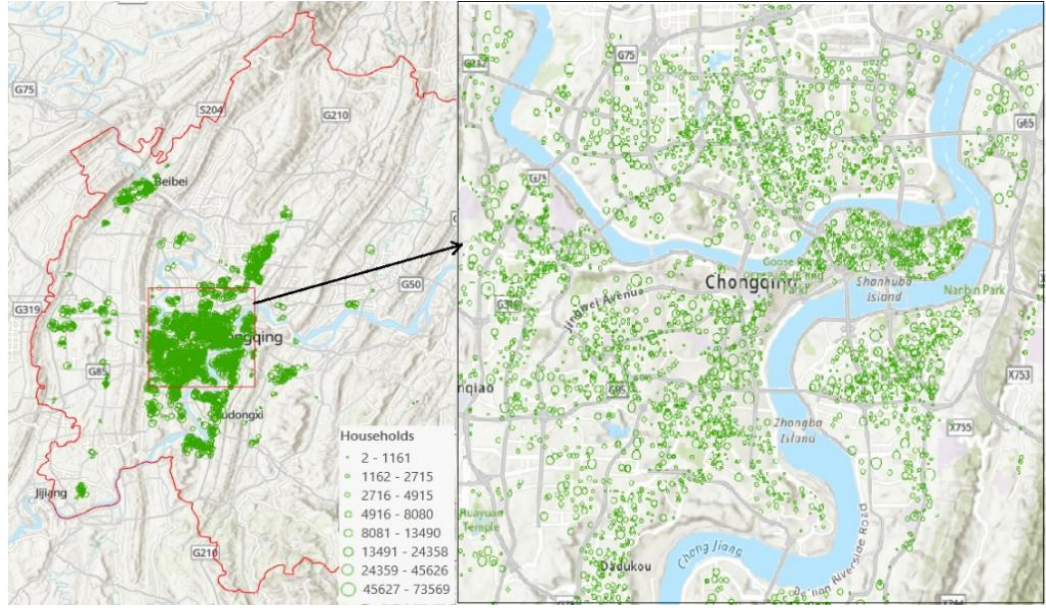
Figure 5. The households of communities in Chongqing.